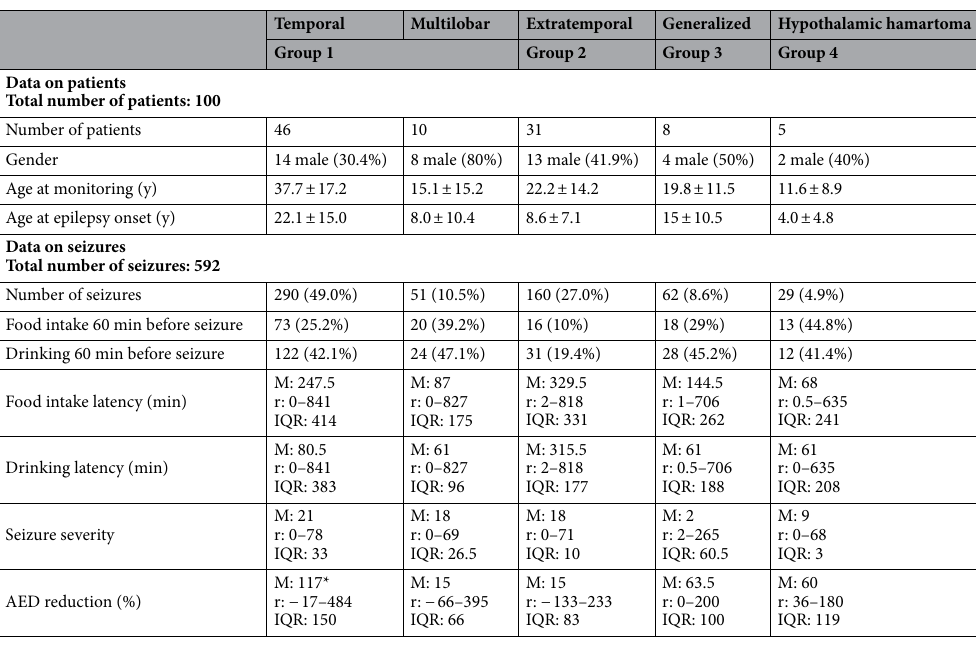
Table 1. General characteristics of patients and seizures. AED : antiepileptic drug; IQR : interquartile range; M : median; min : minutes; r : range; sec : seconds; y : years. *AED reduction values > 100% may appear in patients on polytherapy in whom more than one AED was